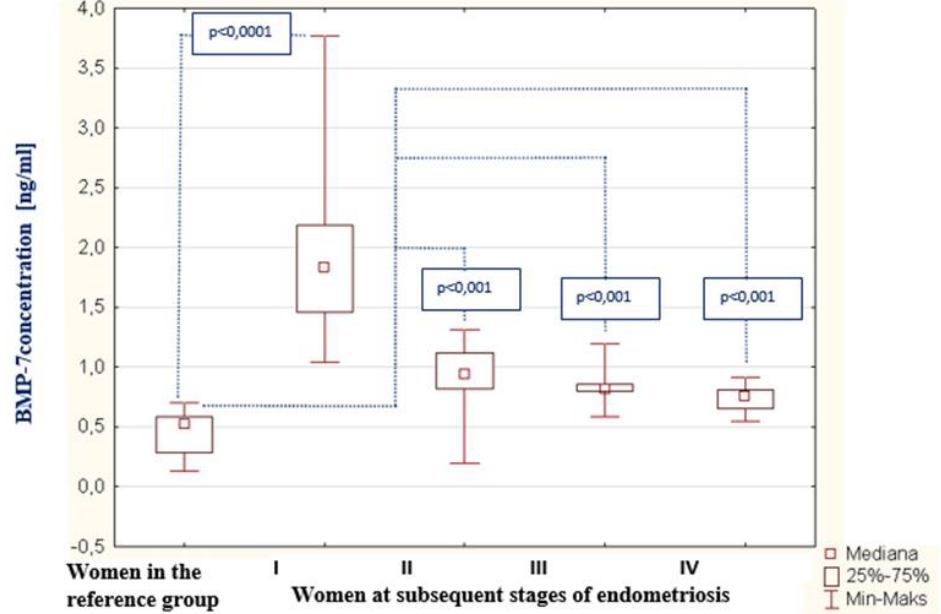
Figure 4. BMP-7 concentration in the peritoneal fluid of women at subsequent stages of endometriosis and women in the reference group.